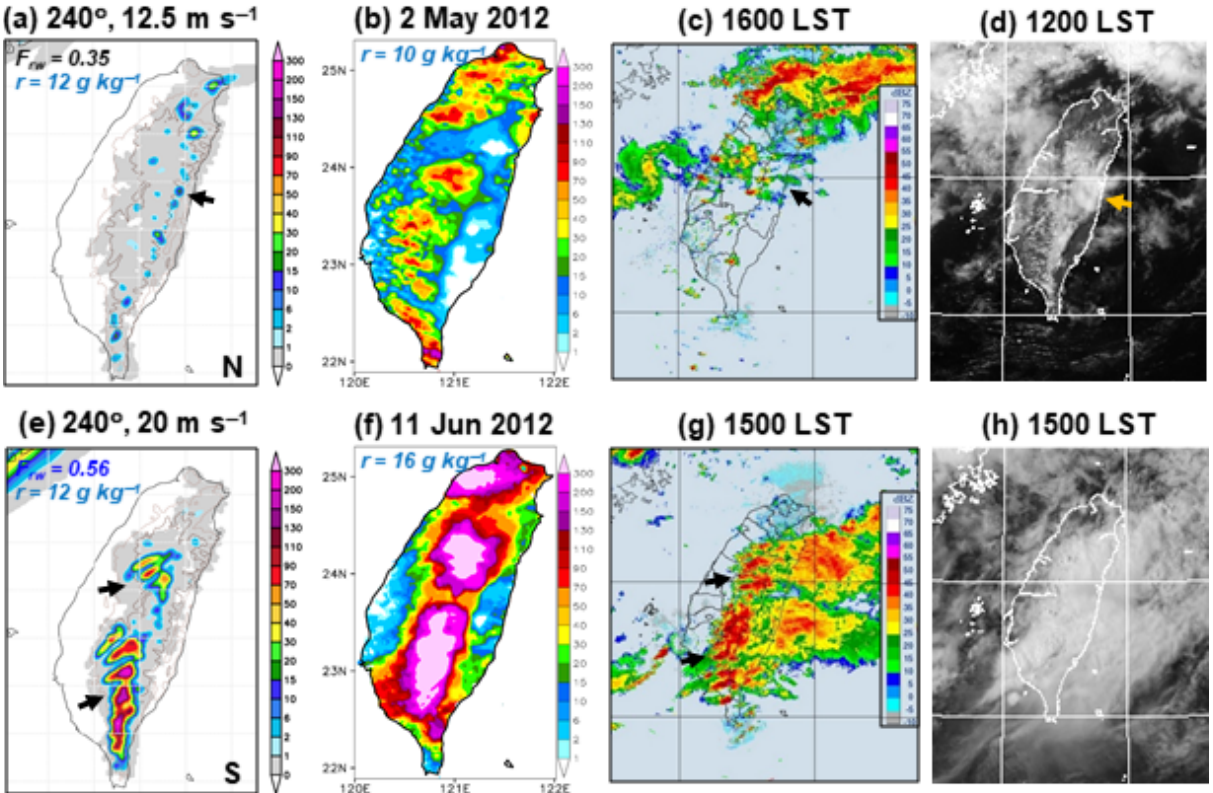
Figure 13. As in Fig. 11 but between idealized results and observations (source: CWB and NCDR) for flow directions from 240 ◦ at an increased speed and thus from the intermediate- to high- Fr w regime. The two idealized cases are (a) 12.5ms − 1 and (e) 20ms − 1 (both from 240 ◦ ), and the corresponding dates under observation are (b–d) 2 May and (f–h) 11 June 2012,